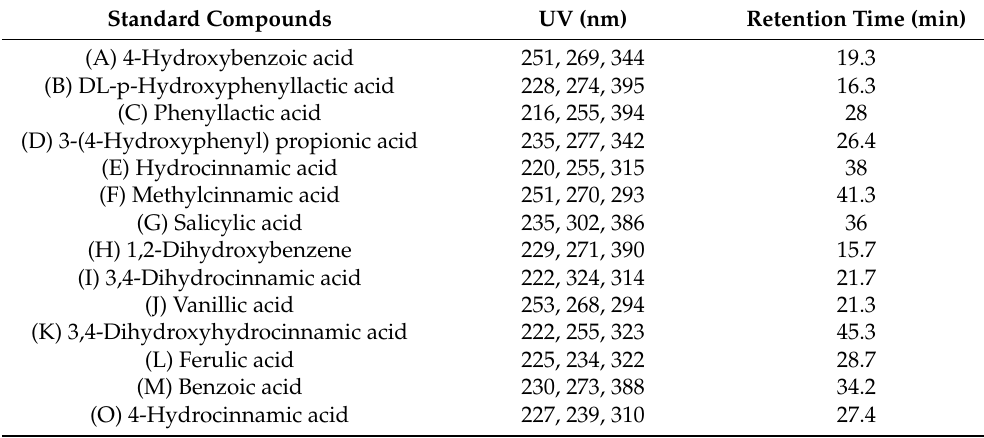
Table 1. Maximum absorbance ( λ max ) of 14 standard compounds determined by HPLC-UV/DAD. Standard